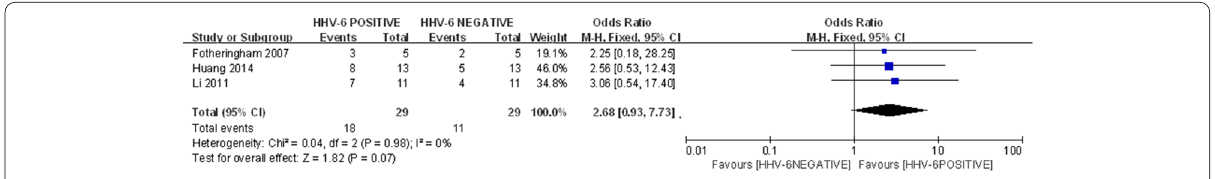
Fig. 3 Forest plots showing the association between HHV-6B and febrile